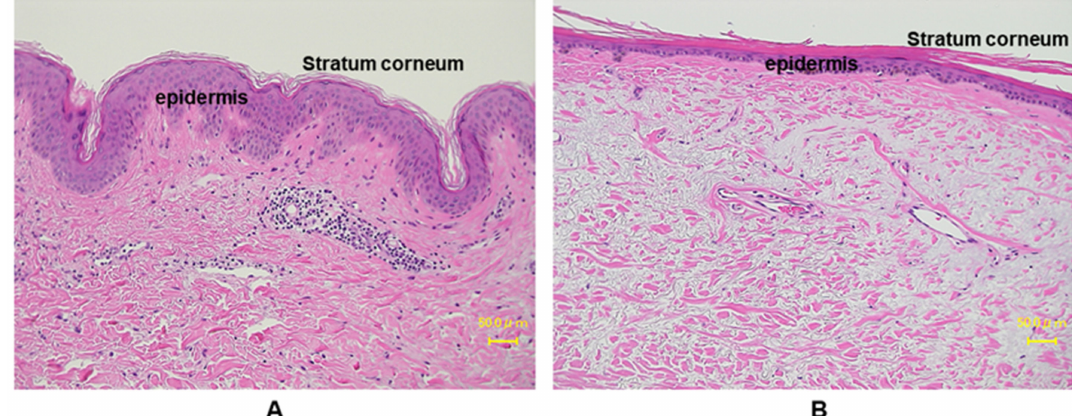
Figure 3. Histological comparison between young and aged photo-exposed human skin. Skin specimens from ( A ) young: 12 years, and ( B ) aged: 77 years, are stained with hemotoxylin and eosin (HE) staining. Aged human skin epidermis is thinner compared to the young skin, as well as the aged dermis displays increased amounts of degenerated elastic fibers.